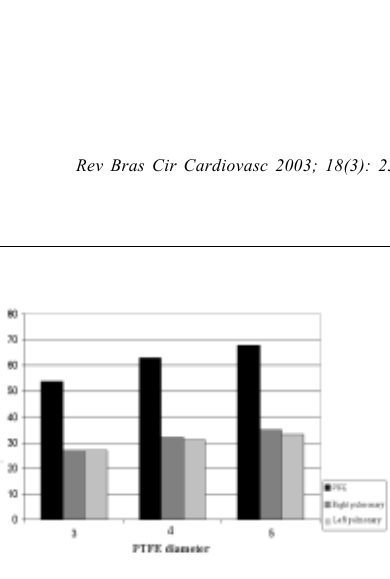
Fig. 2 - Mean percentage of the flow redirected by the graft and distributed by the pulmonary arteries, in respect to the diameter of the PTFE graft. The greater diameters correspond ot the higher percentages of flow, where the distribution of the blood to the pulmonary arteries are constant for any particular angle of anastomose